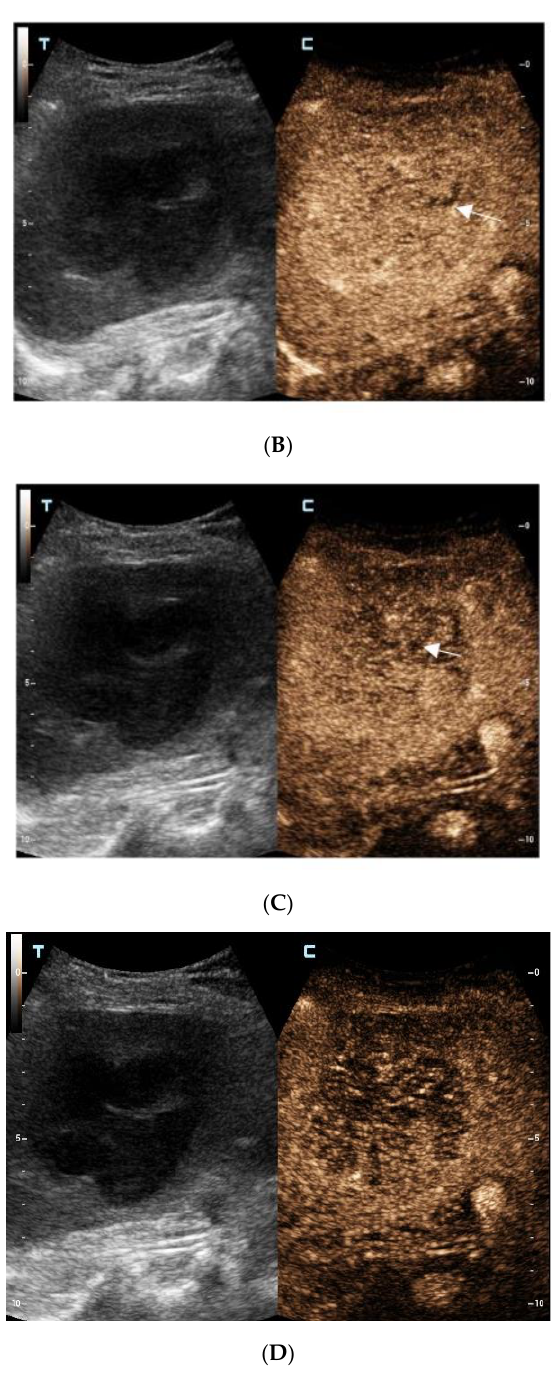
Figure 1. The contrast-enhanced ultrasound images of the hepatic lesion. A 71-year-old man presented at our medical center with intermittent fever in the morning and night for two weeks, accompanied by pain in the back. His body temperature was up to 39 °C, which subsided after anti-inflammatory treatment at the local hospital. He didn’t have a cough, expectoration, chest tightness, or joint pain. The medical history recorded that he had diabetes, hypertension, and suffered tuberculosis ten years ago. Currently, his spot test for mycobacterium tuberculosis (T-Spot) was negative, but his erythrocyte sedimentation rate (ESR) was 72 mm/H (normal range < 28 mm/H) and C-reaction protein (CRP) was 46.4 mg/L (normal range: 0–10 mg/L). Laboratory tests were negative for hepatitis B virus (HBV), hepatitis C virus (HCV), or human immunodeficiency virus (HIV) infection. The serum tumor markers of alpha-fetoprotein (AFP) and CYFRA 21-1 produced negative results, whereas the levels of carcino-embryonic antigen (CEA, 5.9 ng/mL, normal range: 0–5 ng/mL),carbohydrate antigen